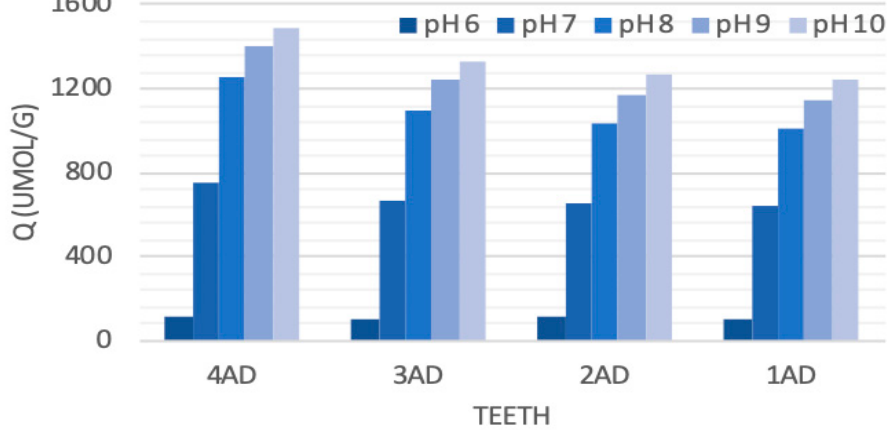
Figure 3. Increase in the consumption of the OH - (titrant) volume during titration of different teeth at increasing pH conditions (1AD-incisors, 2AD-canines, 3AD-premolars, 4AD-molars). The highest consumption of the titrant with the slowest changes in pH was observed between pH 6.5 and 7.0. The distribution function of dissociation constants also showed a clear maximum at a pKapp of about 6.75. This indicated that the largest population of functional groups of the tested materials dissociated, generating a negative charge, in the range of pKapp 6.5–7.0. At the same time, these structures differentiated the tested material the most. The highest intensity of the dissociation constants’ distribution was observed for the 4AD (molars) sample and the lowest for the 1AD (incisors) sample. Both a significant increase in the Q, weak dynamics of pH changes and a clear maximum in pKapp~6.75 may indicate the presence of phosphate groups. These structures are strong buffers, which also explains the large volumes of titrant necessary for sample titration [19]. The buffering maximum at pH~6.75 also indicates that under these conditions the tested materials are the most resistant to pH changes caused by an acidic or alkaline environment. In this case, such resistance decreased towards: 4AD > ≈ 3AD > 1AD ≈ Table 2. Concentration of the macro-elements (± standard deviation) in teeth samples.